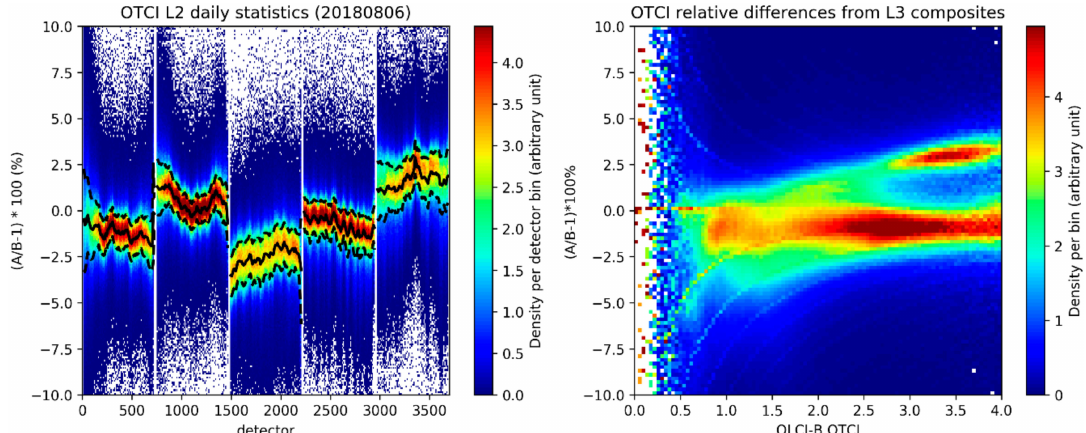
Figure 9. ( Left ): OTCI relative di ff erences of harmonised OLCI-A and OLCI-B over one day statistics (20180806). Results are shown as histograms per bin of OLCI detector. Medians and dispersions added in plain (resp. dashed) lines. ( Right ): the same but computed from all L3 composites over the tandem period. Results are shown as histograms per value of OTCI with OLCI-B taken as reference. From the L3 comparisons, OTCI mean (resp. median) relative di ff erence between OLCI-A and OLCI-B is found to be − 1.2% (resp. − 1.0%). On average, these figures are however better than